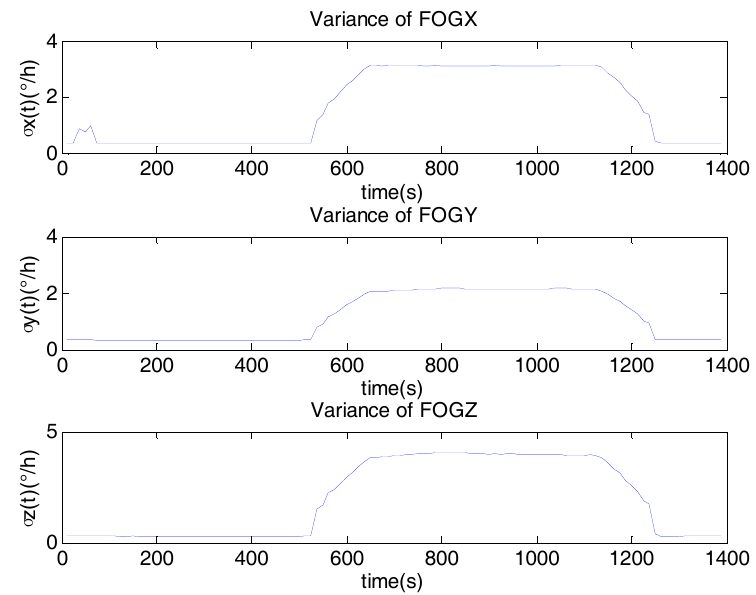
Figure 10. Noise model based on DAVAR.